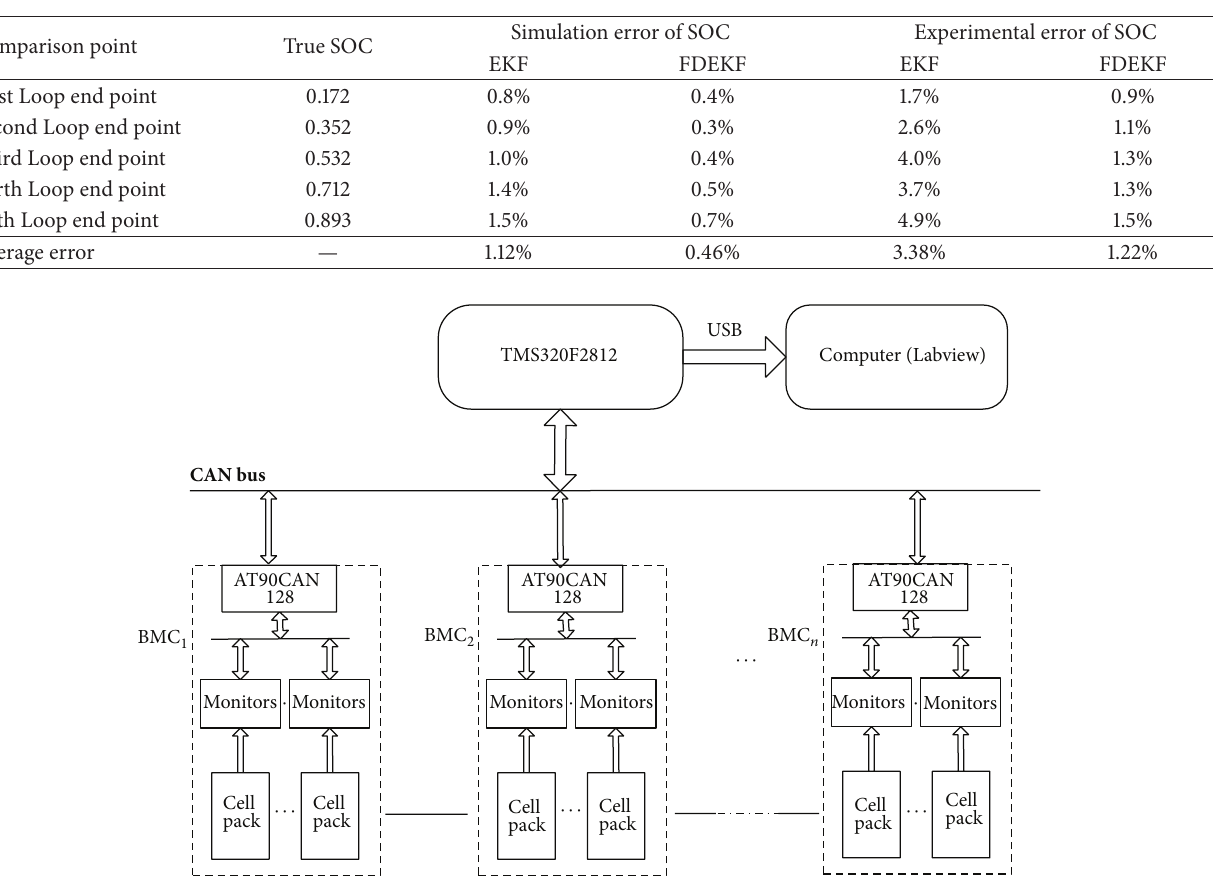
Table 3: Comparison of the simulated and experimental SOC results.